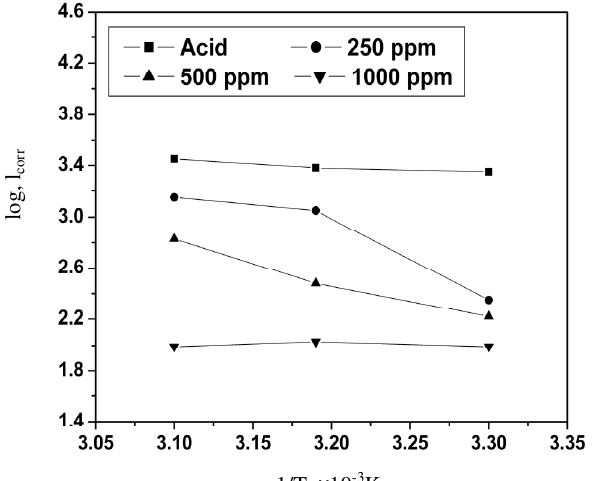
Figure 7. Variation of corrosion current with temperature in 1 N H